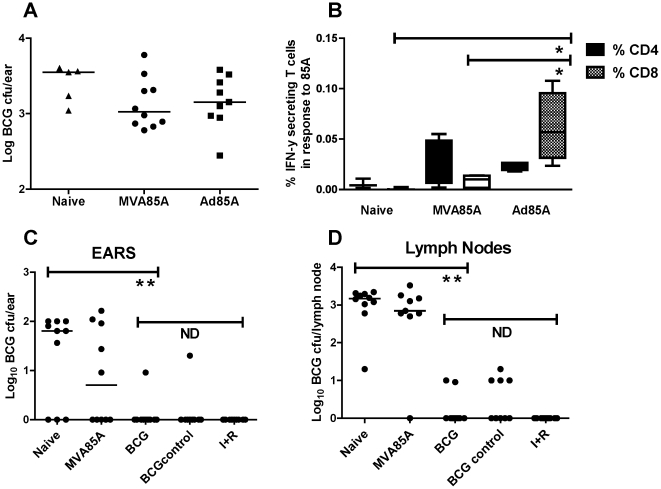
Effect of single dose vaccines (subunits MVA85A and Ad85A, and BCG) on an id BCG challenge.(a) BALB/c mice were immunized id with 1×106 pfu MVA85A or 2×109 vp Ad85A. Control mice (Naïve) received no immunization. Four weeks later all mice were challenged id with 1×105 CFU BCG, contralaterally to the site of vaccination. Ears and LNs were harvested 4 weeks after BCG challenge and processed for CFU quantification. (*P<0.05, n = 10 except naïves, n = 5). (b) Corresponding intracellular cytokine staining (ICS) of the local draining LNs. Red bars represent the proportion of IFN-γ-secreting CD4+ T cells in response to 85A, blue bars represent the same for CD8+ T cells (M, n = 4; Naïve, n = 3; Ad, n = 4. *P<0.05). (c) Effect of BCG vaccine compared to subunit MVA85A on an id BCG challenge. BALB/c mice were immunized id with either 1×106 pfu MVA85A or 2.2×104 cfu BCG. “Naïve” and antibiotic-treated (I+R) mice received no immunization. Four weeks later all mice were challenged with 6×103 CFU BCG, except the BCG control group who received no challenge. In the I+R group, challenge was followed by 4 weeks treatment with isoniazid and rifampicin. Ears and LNs were harvested 4 weeks after BCG challenge and processed for CFU quantification. Log10 BCG CFU individual data points for each mouse are shown. Bars represent the median per group. (c) Ears (**P<0.01, “non-significant, ND”, n = 10); (d) LNs (**P<0.01, “non-significant, ND”, n = 10).